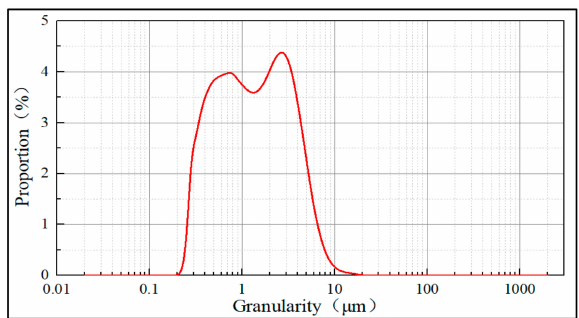
Figure 16. Particle size distribution of drilling